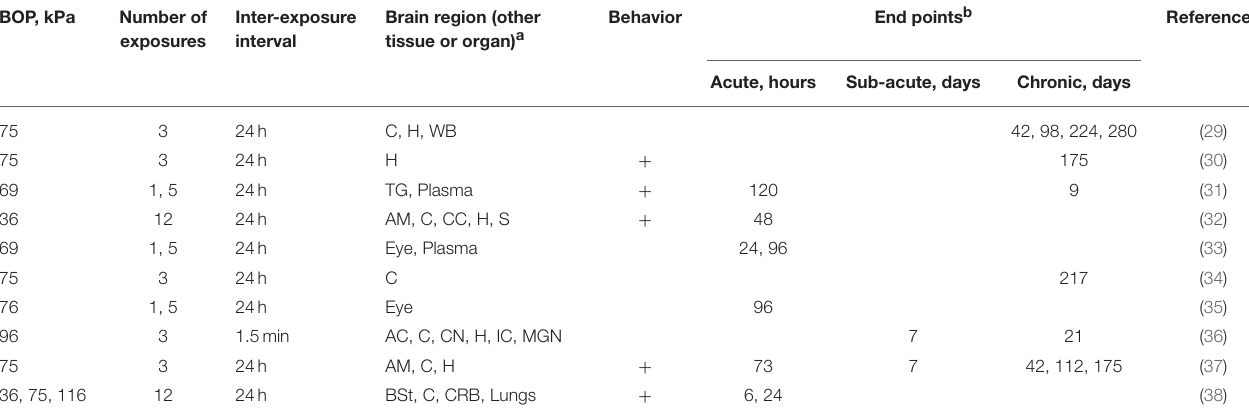
TABLE 1 | The summary of experimental variables (exposure conditions: BOP, number of exposures and inter-exposure interval, analyzed brain region, tissue or organs, behavioral testing and end points) in studies using Long Evans rats. BOP, kPa Number of Inter-exposure Brain region (other exposures interval tissue or organ)